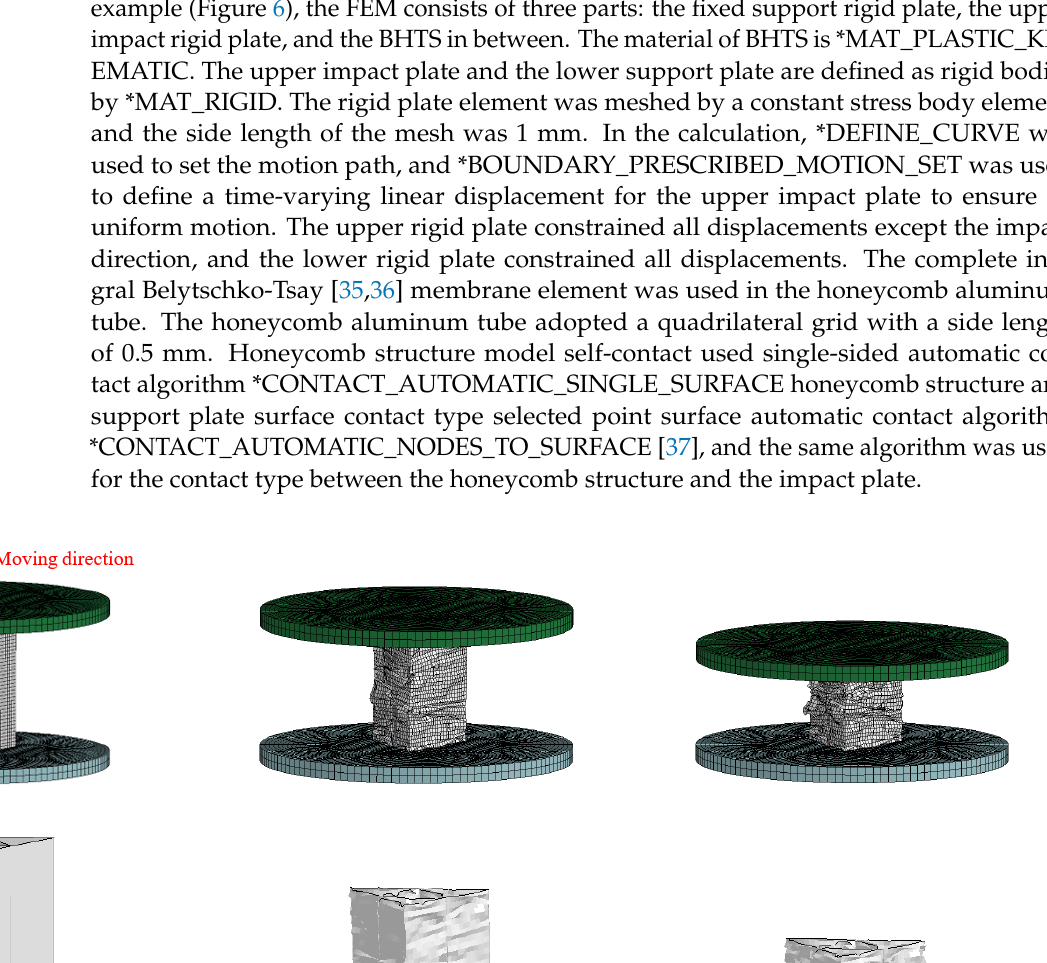
Table 2. Properties of Si ‐ Al alloy AlSi10Mg.